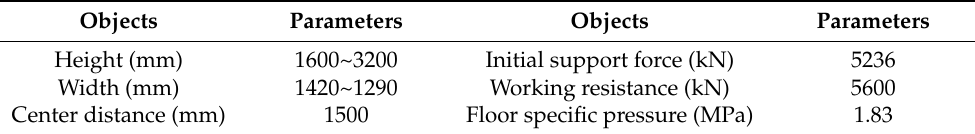
Table 1. The basic parameters of the ZFS5600/16/32 top-coal caving hydraulic support.